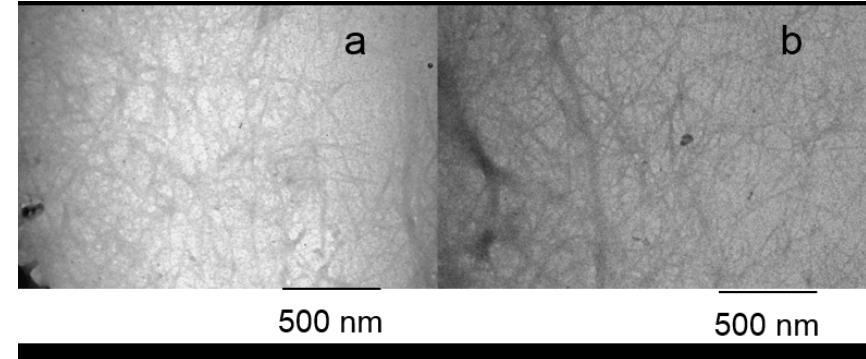
Figure 2. Micrographs obtained using TEM of the cellulose nanofibers from rice hulls: extraction at 1 h (a), and 2 h (b).